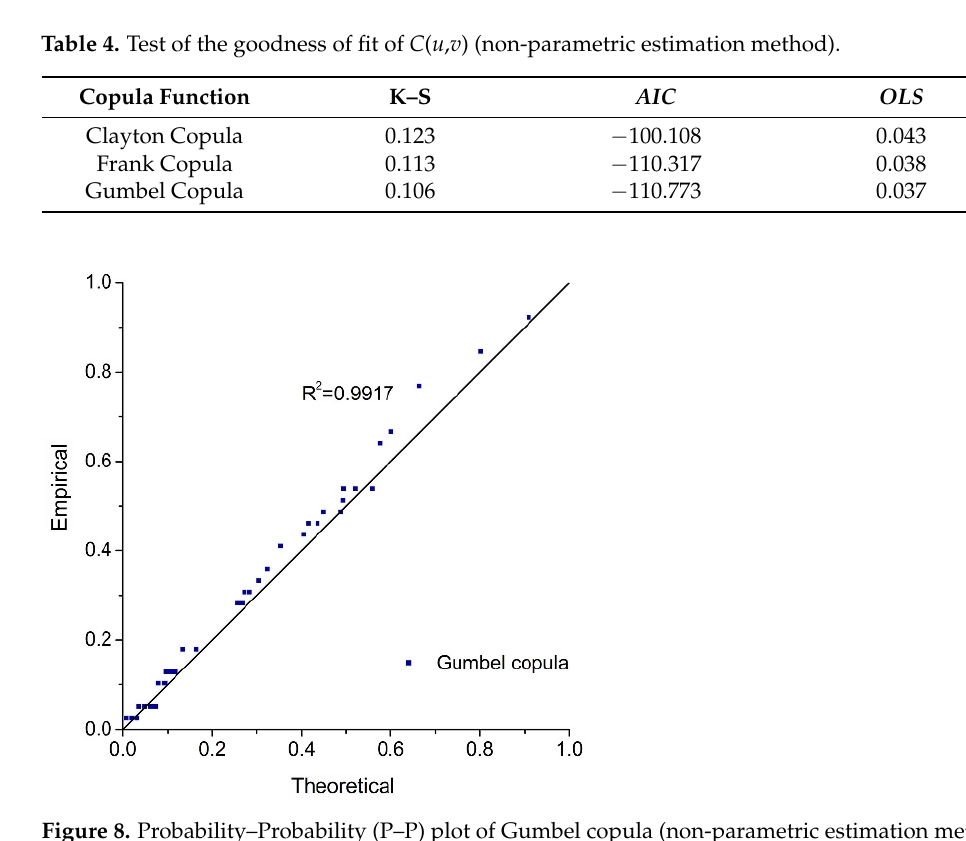
Figure 7. Bivariate rank-plots of the marginals of precipitation and storm tides.